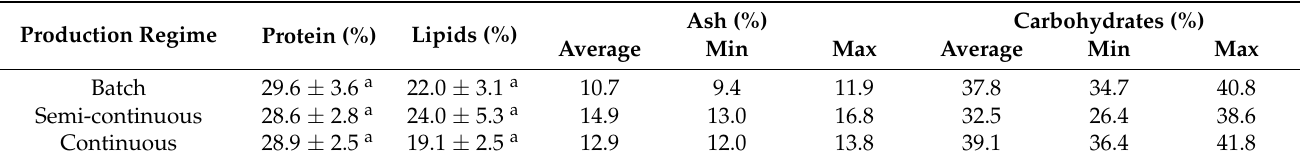
Table 3. Proximate composition, in percentage of total dry weight, of Nannochloropsis oceanica grown in 2.6 m 3 tubular PBRs, using different operation regimes. For proteins and lipids, the values represent the average and standard deviation of two biologically independent replicates and two analytical replicates. Different letters within the same column represent significantly different values. Regarding ashes and, consequently, carbohydrates, the presented values are the average of two biological replicates and the minimum and maximum values ( p -value <